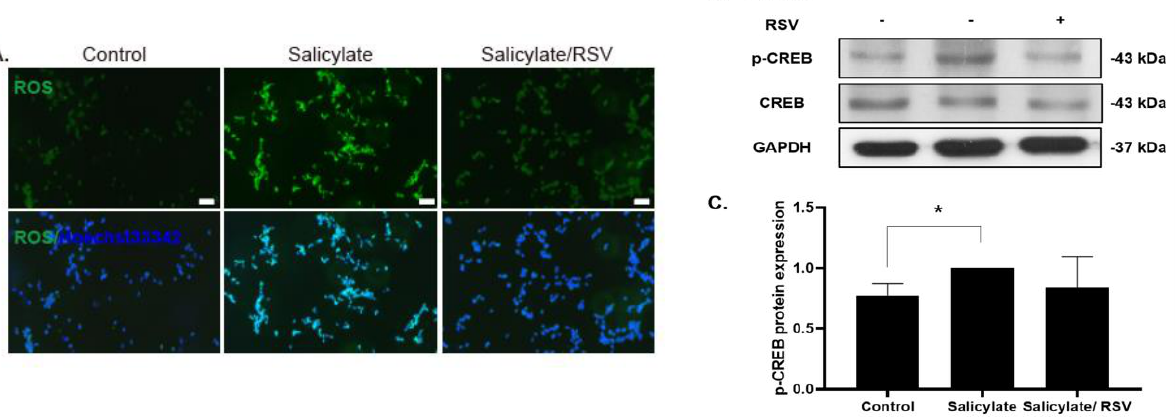
Figure 2. Phosphorylation of cAMP response element-binding protein (CREB) was reduced in resveratrol (RSV)-pretreated neuronal cells. Salicylate treatment induced CREB phosphorylation, which was reduced in RSV-pretreated SH-SY5Y cells as shown by immunocytochemistry staining ( A ) (scale bar = 100 µm) and immunoblot analysis ( B ). Western blot data were quantified and presented as a graph ( C ); * p < 0.05, mean ± SD. GAPDH was used as the internal standard. Scale bar = 100 um.